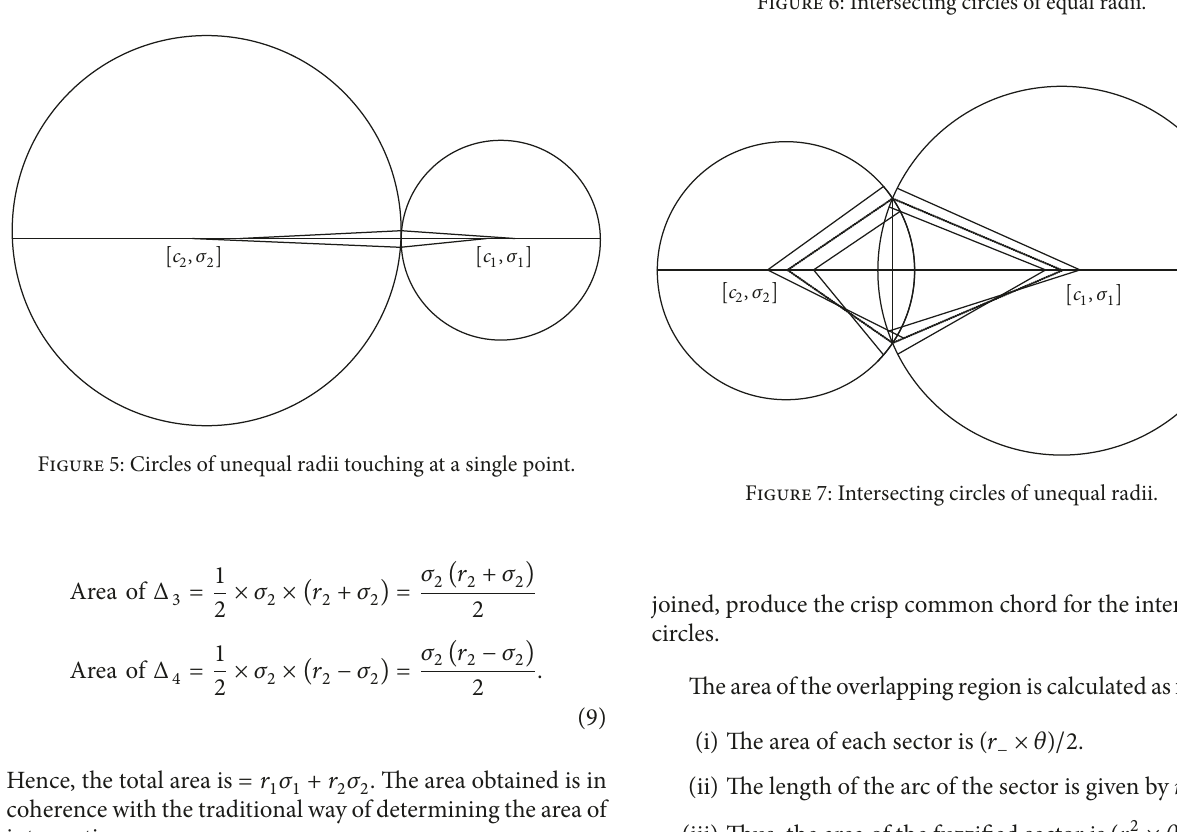
Figure 6: Intersecting circles of equal radii.